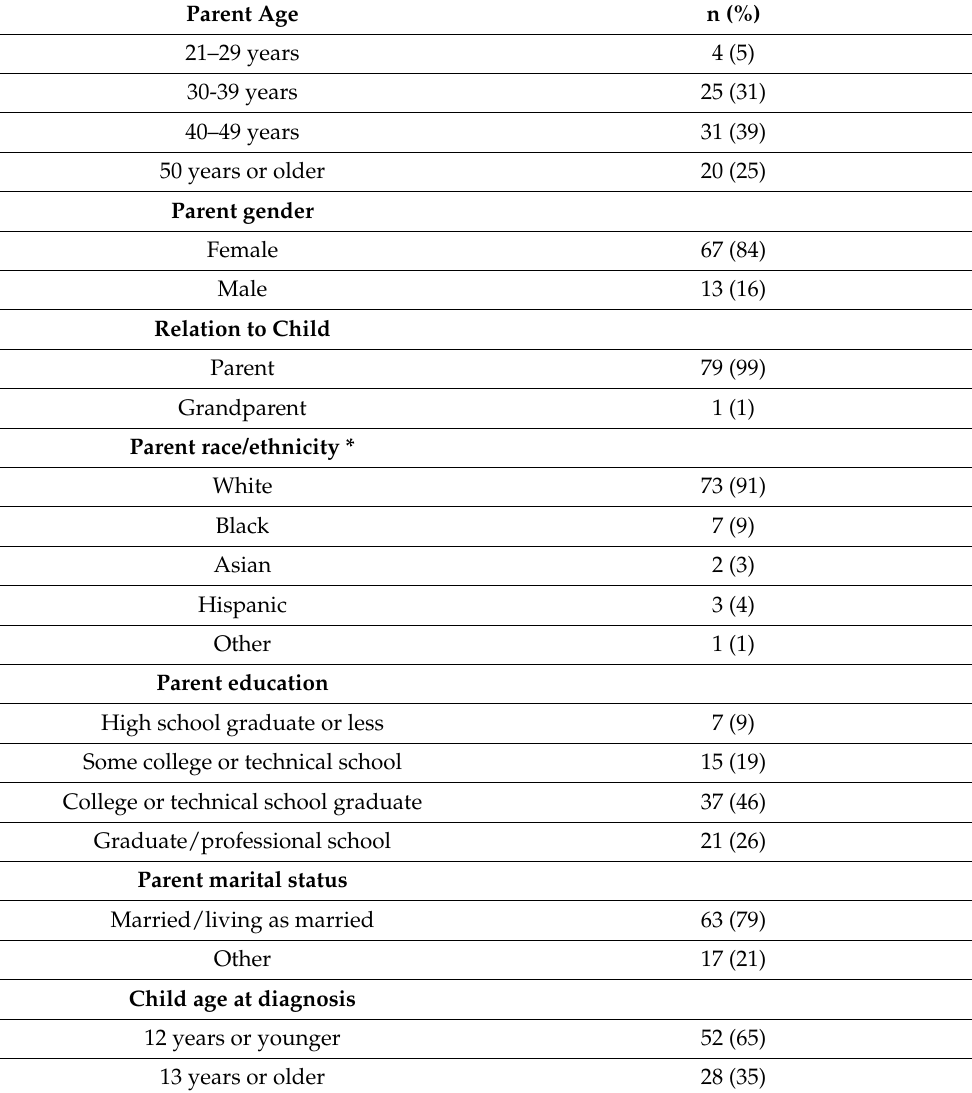
Table 1. Patient and Parent